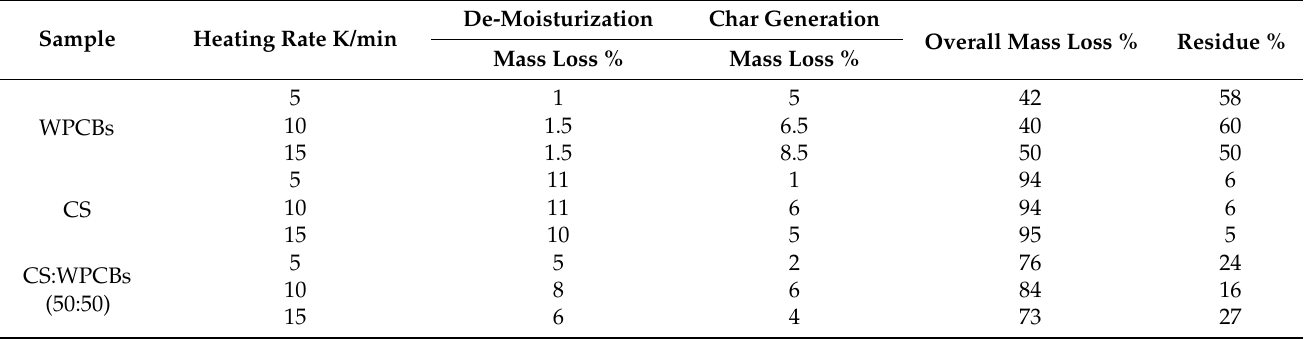
Table 5. Mass loss for de-moisturization and char